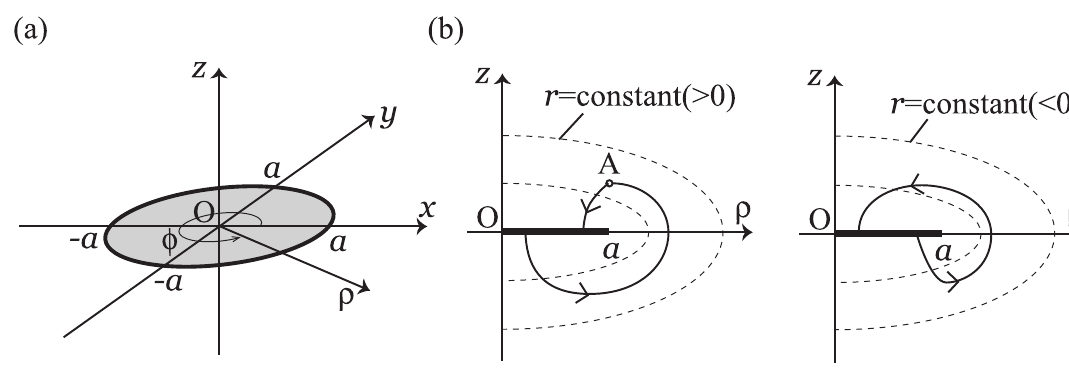
Figure 2 . (a) The Cartesian coordinates ( x, y, z ) and the cylindrical coordinates ( ρ, φ, z ) and (b) the domains of r > 0 (left) and r < 0 (right). A closed curve γ from a point A wraps around a ring at ( ρ, z ) = ( a, 0) by crossing twice a disk defined by ρ ∈ [0 , a ) with z = 0